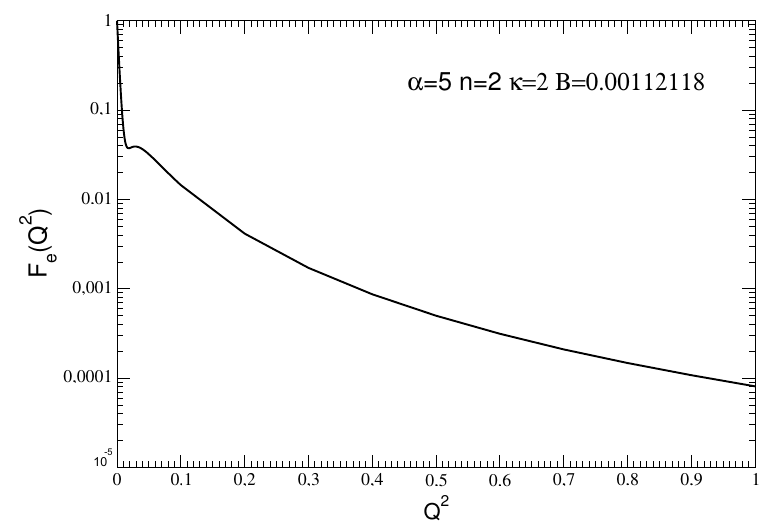
Figure 13. Elastic form factors of the abnormal state n = 2, κ = 2—No. 4 of Table 1. (Adapted from